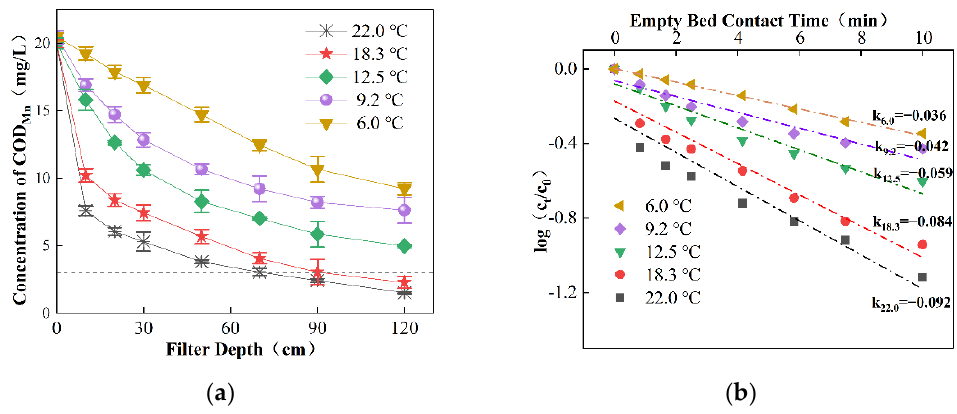
Figure 6. ( a ) The concentration changes of COD Mn along with the filter depth, ( b ) linear regression analysis of COD Mn depletion with the EBCT at different temperatures.